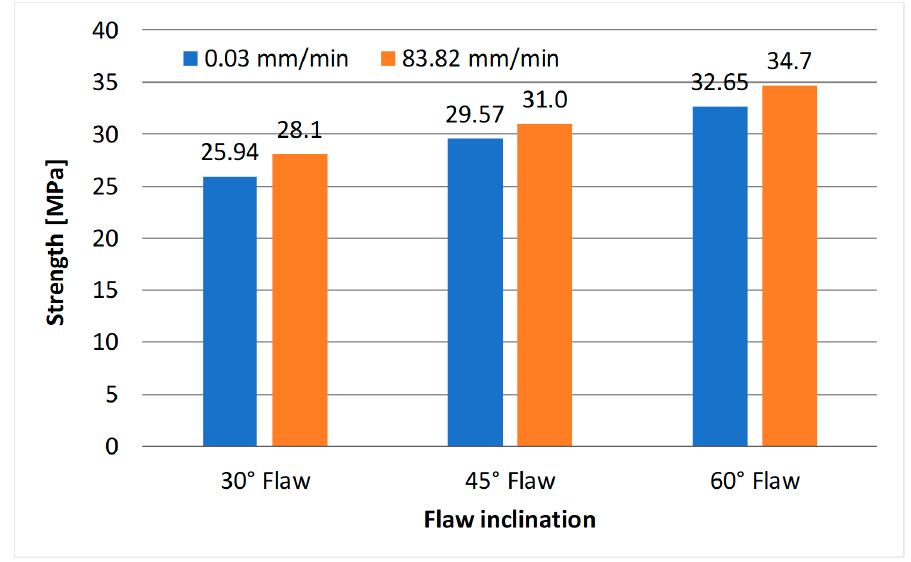
Figure 8. Variation of strength with the different loading rate.